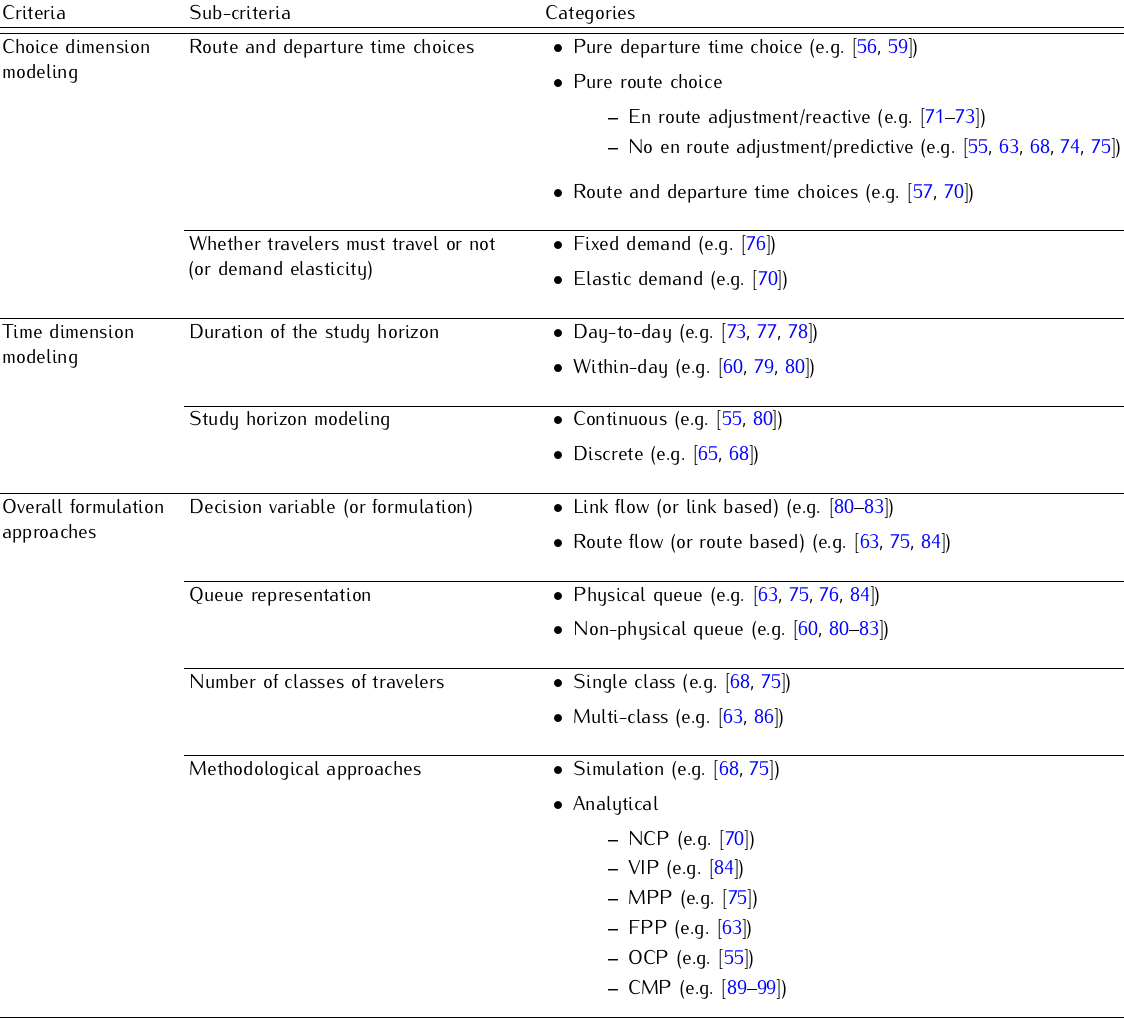
Table 5. Criteria for classifying DTA